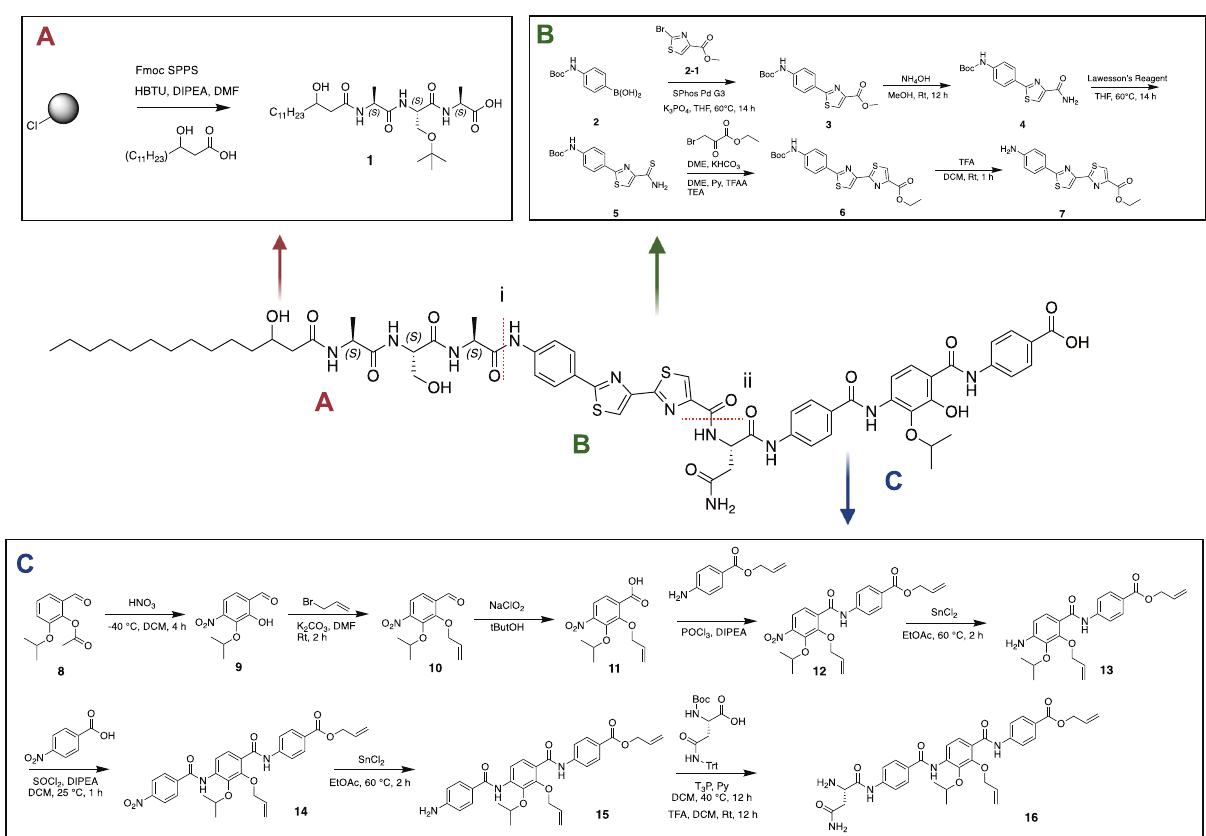
Fig. 3 Overview of the synthesis of lapcin. Lapcin was synthesized in three fragments A – C which were coupled using a series of amid bond forming reactions. i Coupling fragment AB ( S18 ): isobutyl chloroformate, TEA, THF. ii Coupling AB ( S18 ) to fragment C ( 16 ): HBTU, DIPEA,